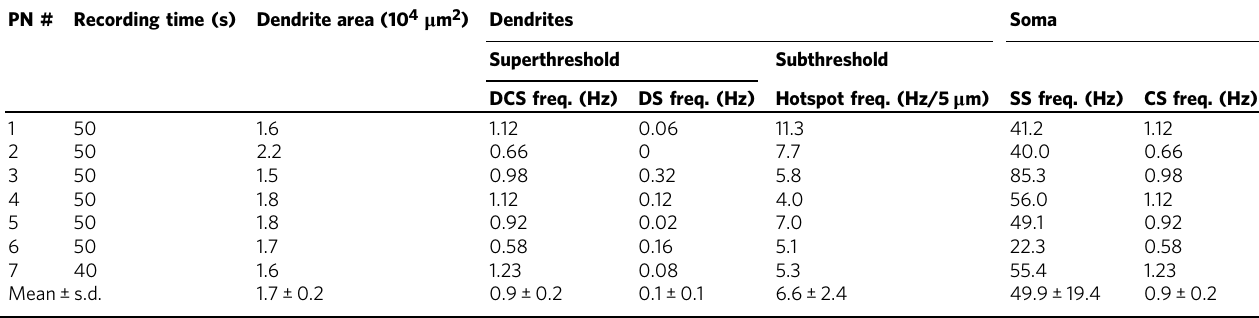
Table 1 Summary of supra- and subthreshold dendritic signals and somatic activity of PN in awake mice PN # Recording time (s) Dendrite area (10 4 μ m 2 )